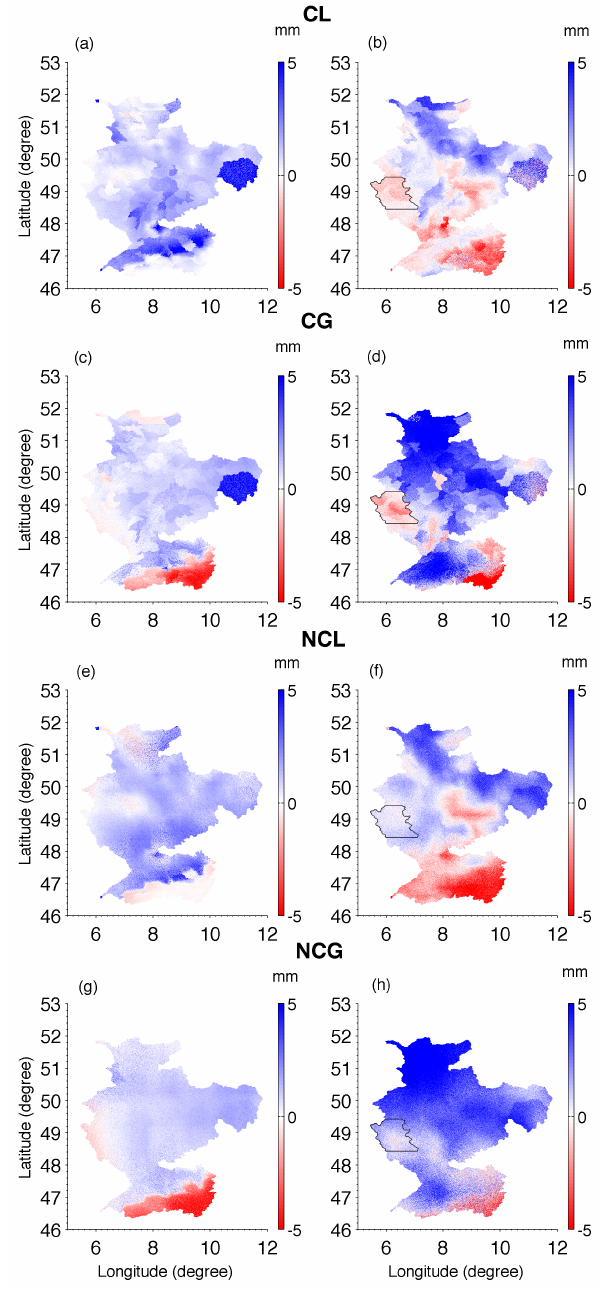
Figure 6. Averaged increment (posterior minus prior) of TWS in mm during the winter 2005–2006 (left panels) and summer of 2006 (right panels) in four different scenarios (CL: calibrated parameters with local forcing data; CG: calibrated parameters with global forc- ing data; NCL: non-calibrated parameters with local forcing data; NCG: non-calibrated parameters with global forcing data). The polygons in the right column define the southern part of Moselle